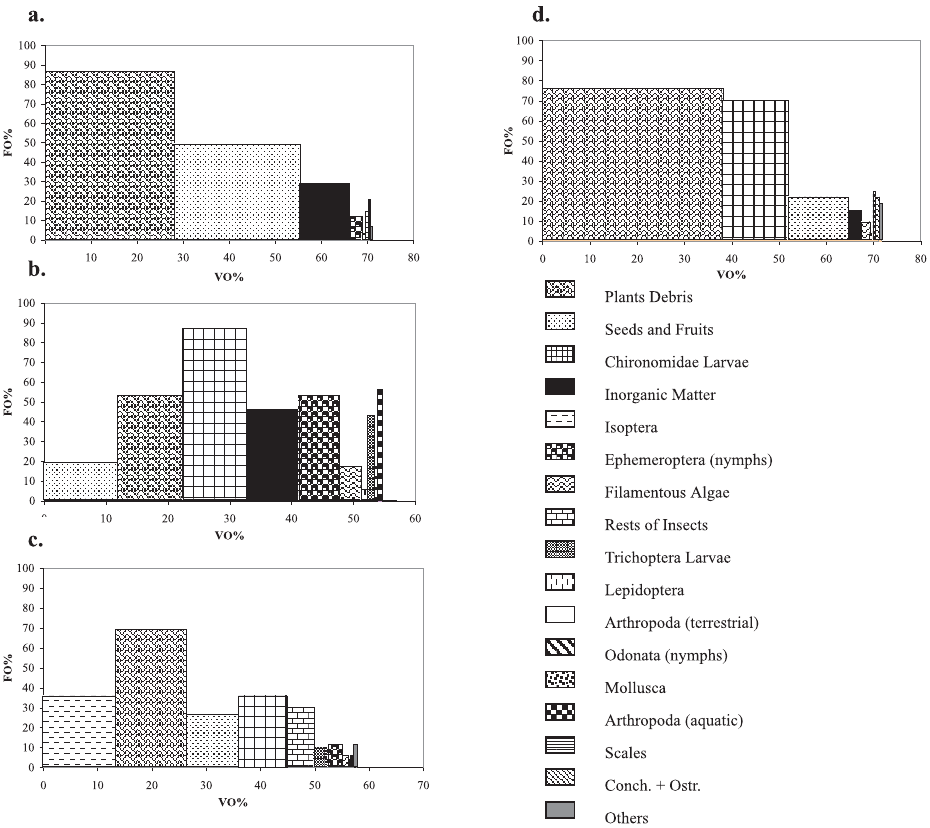
Fig. 2. Representation of the main food items, except organic matter (OM), in the diet of Leporinus taeniofasciatus in the upper rio Tocantins, region of Serra da Mesa. a. River/ flood; b. River/ drought; c. Reservoir/ flood; d. Reservoir/